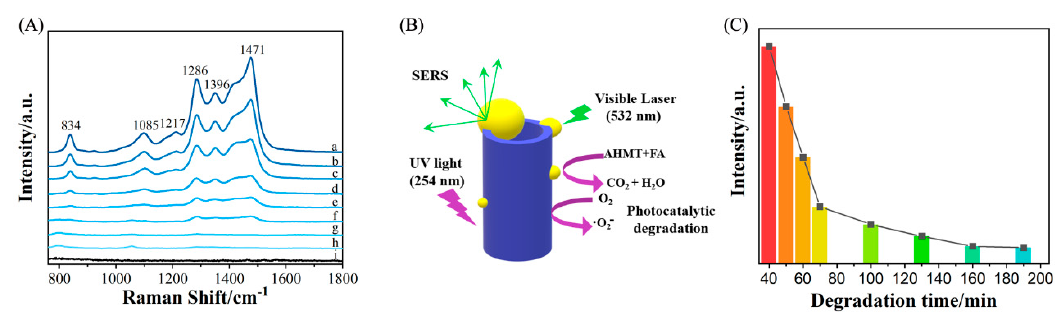
Figure 6. ( A ) SERS spectra of AHMT + MTT on the Ag-coated TNA substrate surface after ( a ) 40, ( b ) 50, ( c ) 60, ( d ) 70, ( e ) 100, ( f ) 130, ( g ) 160 and ( h ) 190 min of catalytic degradation by UV irradiation; ( i ) Raman spectrum of the Ag-TNA substrate without adsorbate. ( B ) Schematic of UV-degradable organics on the SERS substrate. ( C ) Plot of the Raman band intensity of 1.44 × 10 − 4 M MTT at 1286 cm − 1 as a function of degradation time.